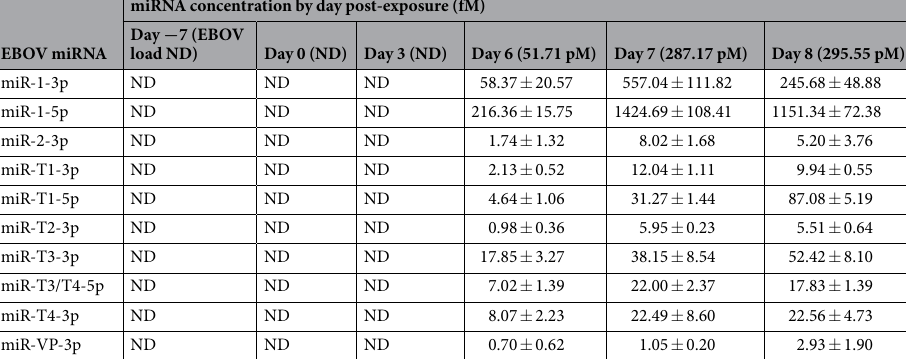
Table 1. EBOV miRNAs were detected in rhesus macaques exposed to aerosolized EBOV/Kikwit. Note: Data are presented as the mean ± SD of biological replicates assayed in technical triplicate. The corresponding EBOV load at each timepoint is given in parentheses below each day. ND = not detected.